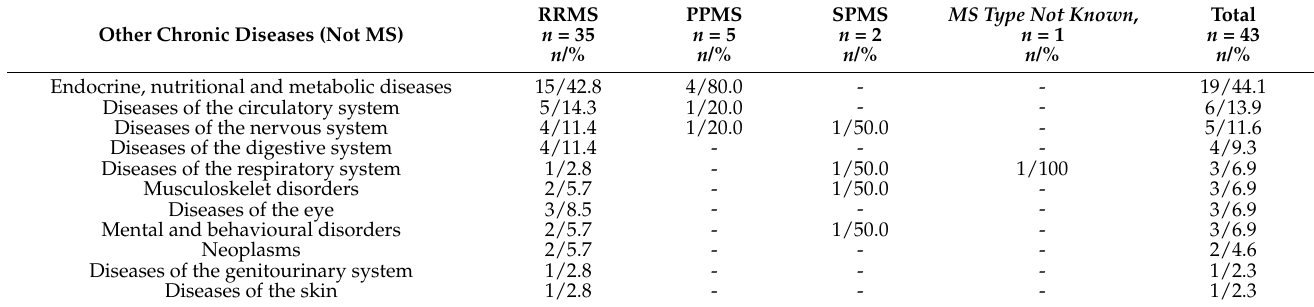
Table 3. Percentages of comorbidities in the participants (N = 43).